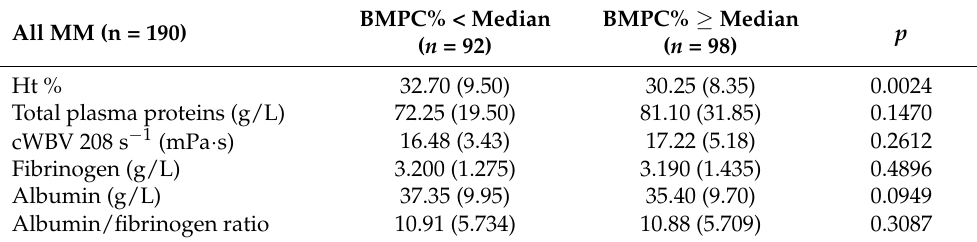
Table 8. Medians (IQR) of hemorheological determinants in all MM patients subdivided according to the median of